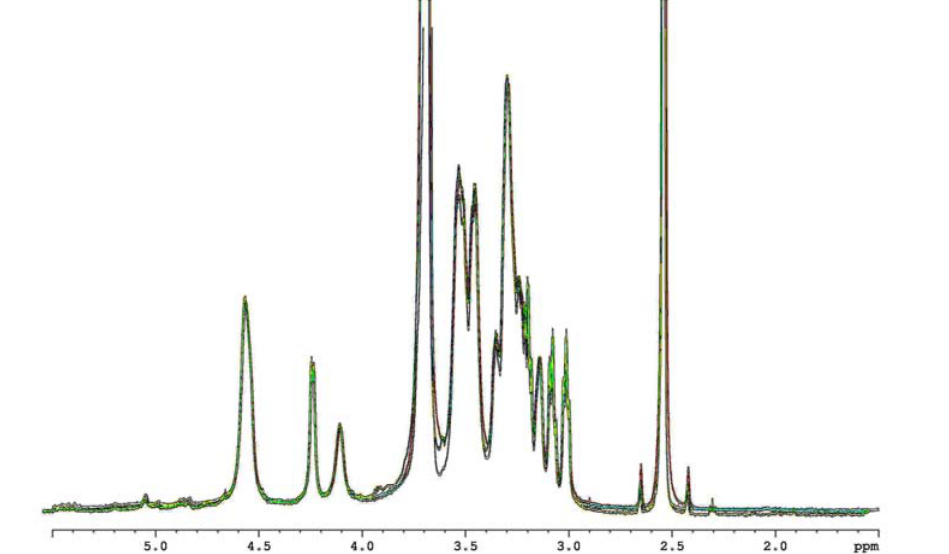
Figure 2. 1 H-NMR spectra at 600.13 MHz and 27 °C (DMSO- d dialysed Sclg (green), Sclg sonicated 30 min (red) and Sclg sonicated 60 min